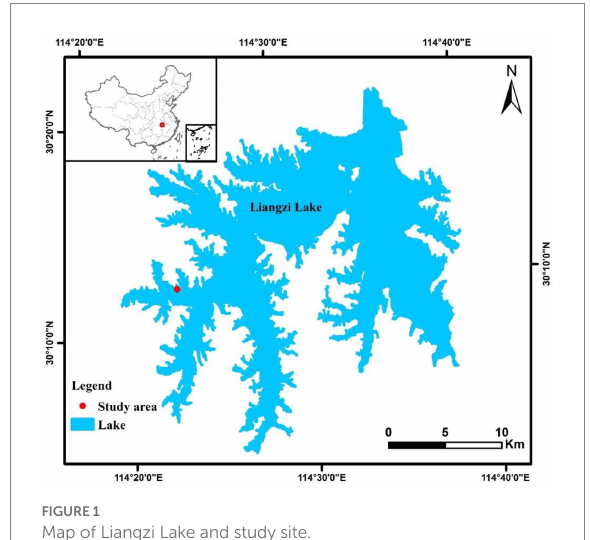
FIGURE 1 Map of Liangzi Lake and study